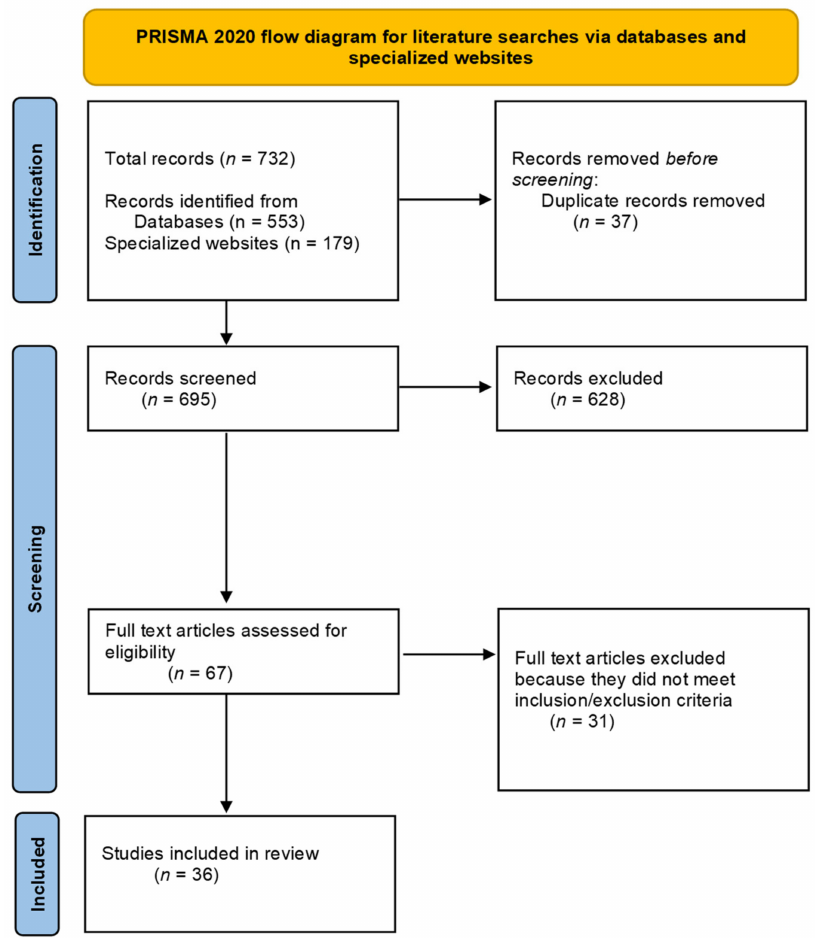
Figure 1. Flowchart showing the study selection process